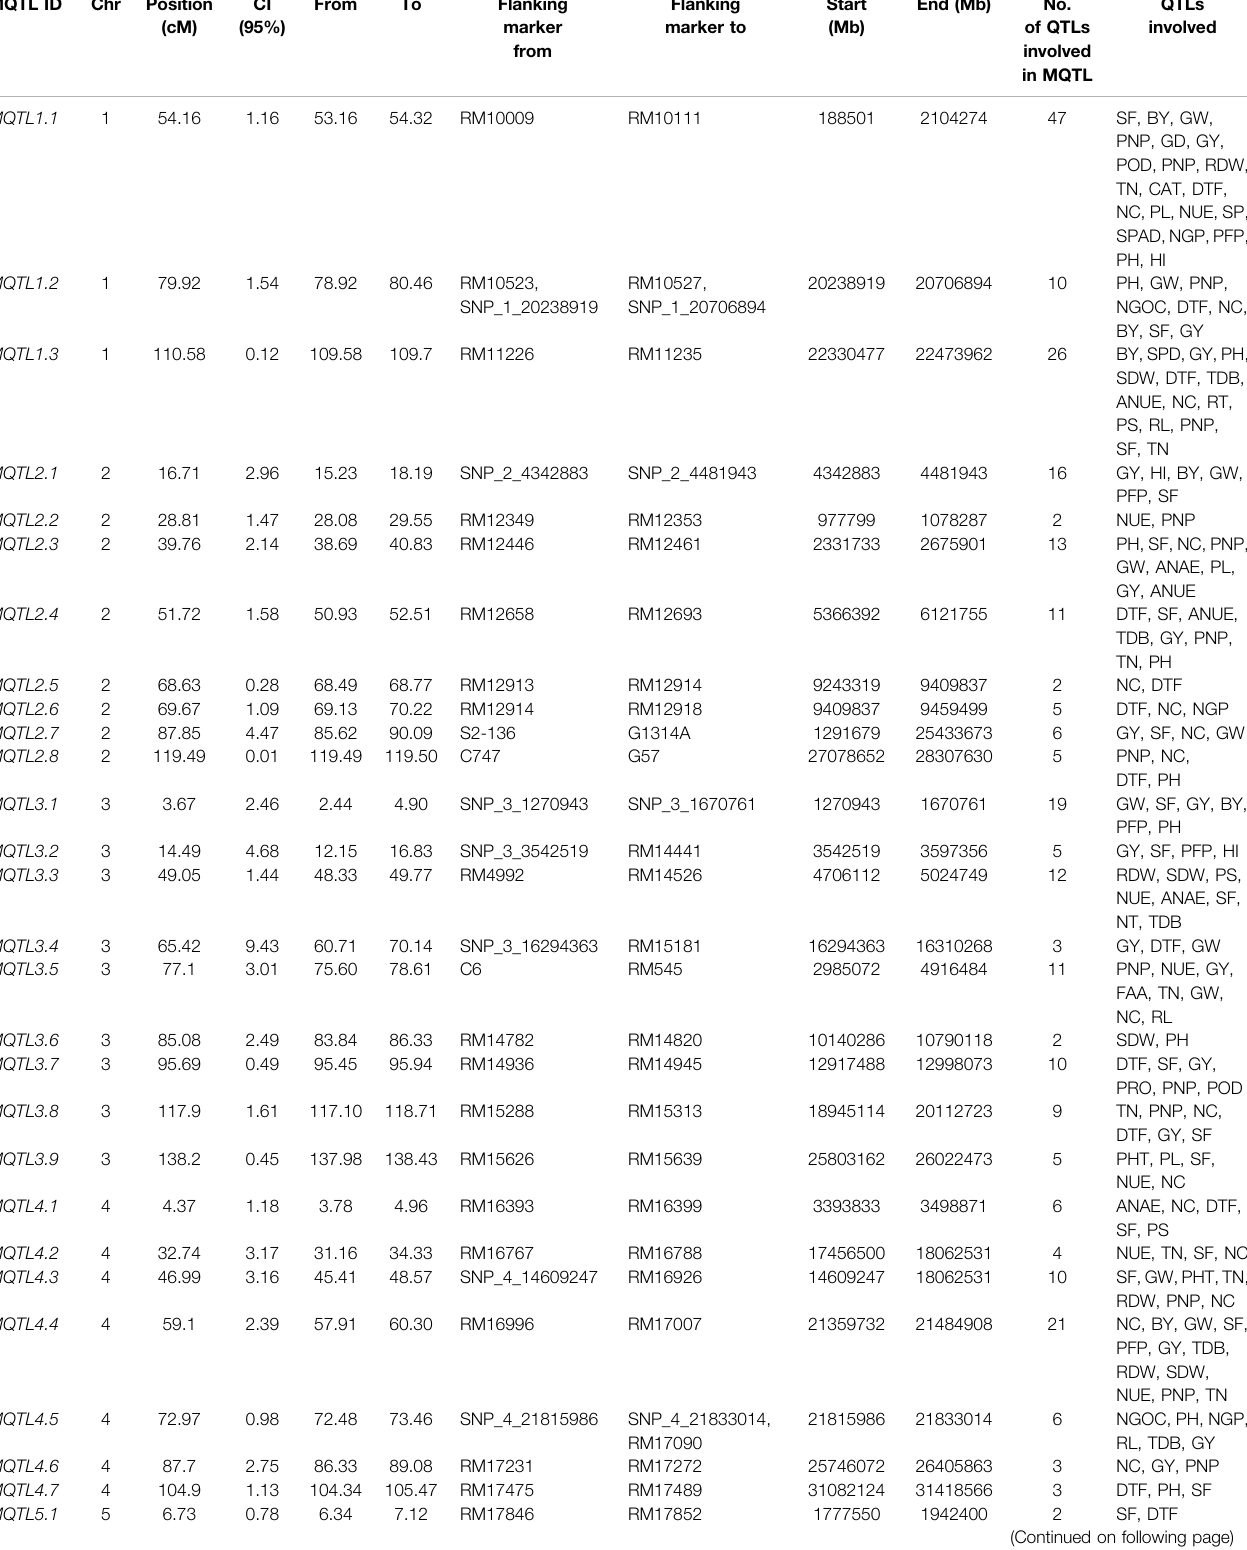
TABLE 3 | Summary of the detected MQTLs for the nitrogen use ef fi ciency and related traits in rice. MQTL